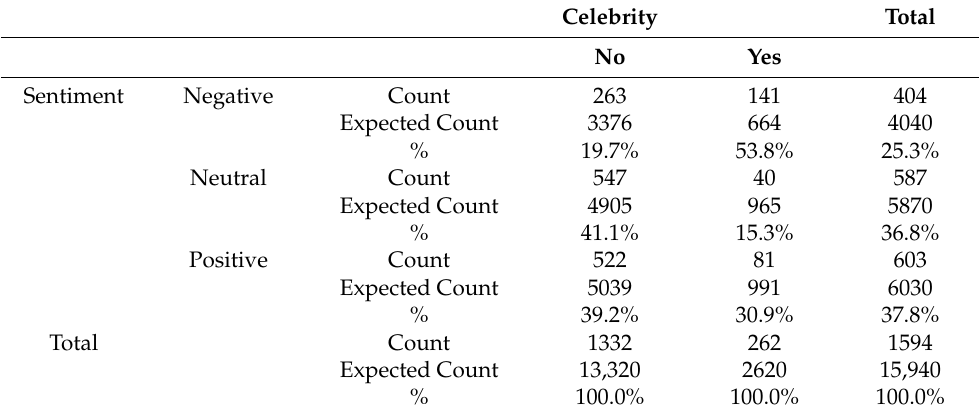
Table 5. Frequency of each sentiment in news stories with or without celebrities in our